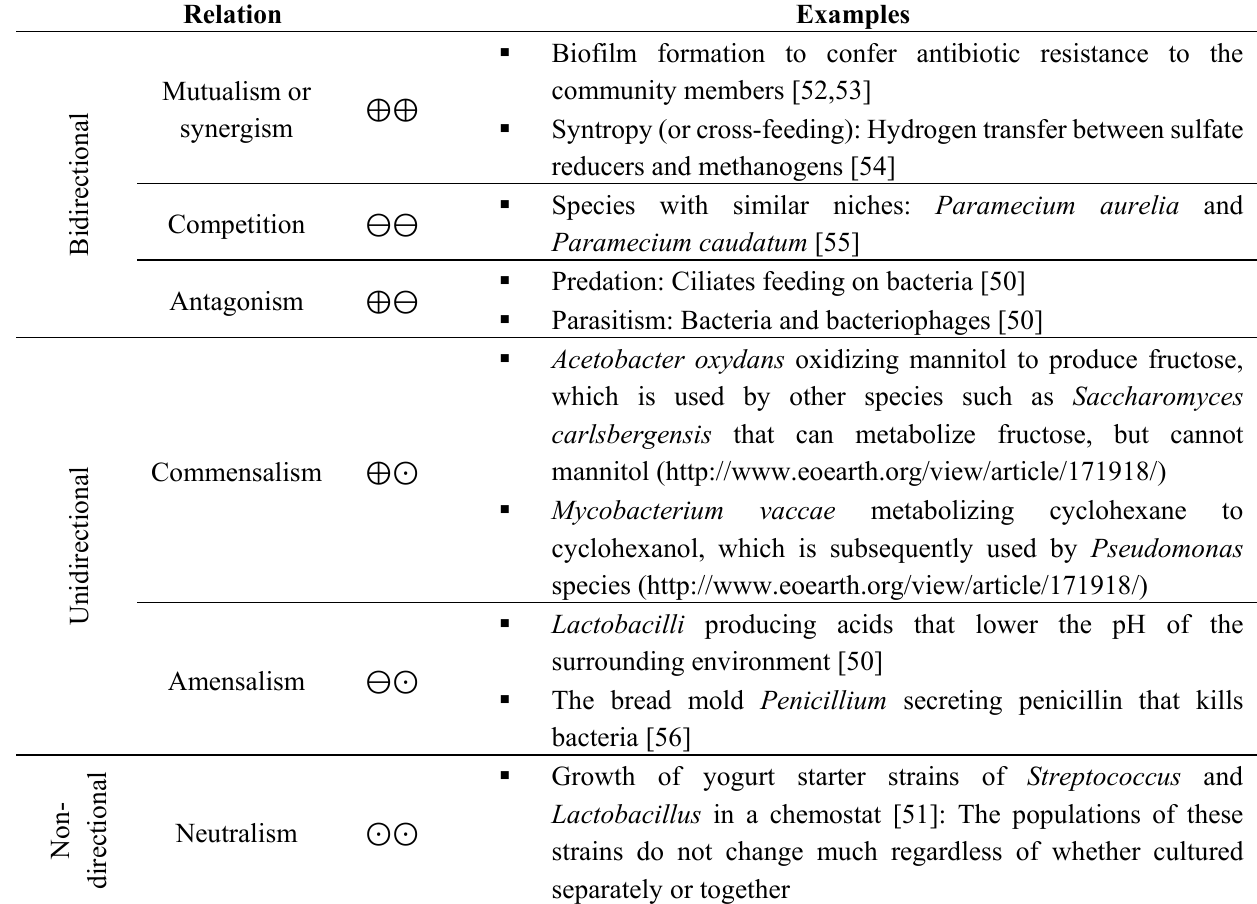
Table 1. Forms of microbial interactions: The positive, negative, and neutral impact of one species on another is represented by